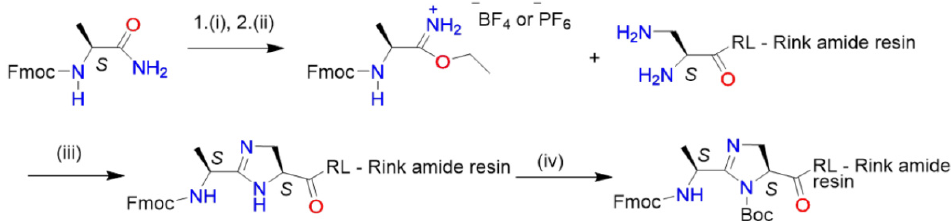
Figure 3 . Synthesis of the iminoether 2 derived from Fmoc-L-Ala-NH 2 1 , followed by ring formation on solid support: (i) 1.1 eq. triethyloxonium tetrafluoroborate or triethyloxonium hexafluorophosphate in DCM, rt, 2 h; (ii) washing with 1 M KHCO 3 aq., overnight drying over anhydrous MgSO 4 ; (iii) DIEA/DCM, rt, overnight; (iv) Boc 2 O/DIEA, rt, 3 h.